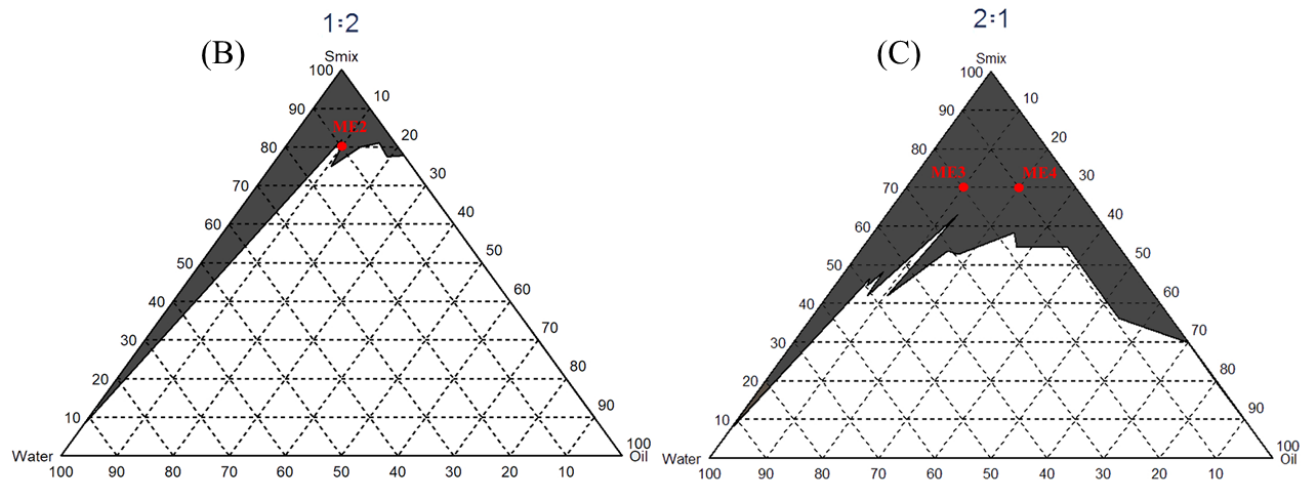
Figure 2. The pseudoternary phase diagram of the microemulsion formation with different tween 80 and ethanol ratios. The black area indicates the microemulsion formation. Red dots indicate the selected formula, which produces the microemulsion with less surfactant. ( A ) A 1:1 ratio of tween 80: ethanol, ( B ) a 1:2 ratio of tween 80: ethanol, and ( C ) a 2:1 ratio of tween 80: ethanol.